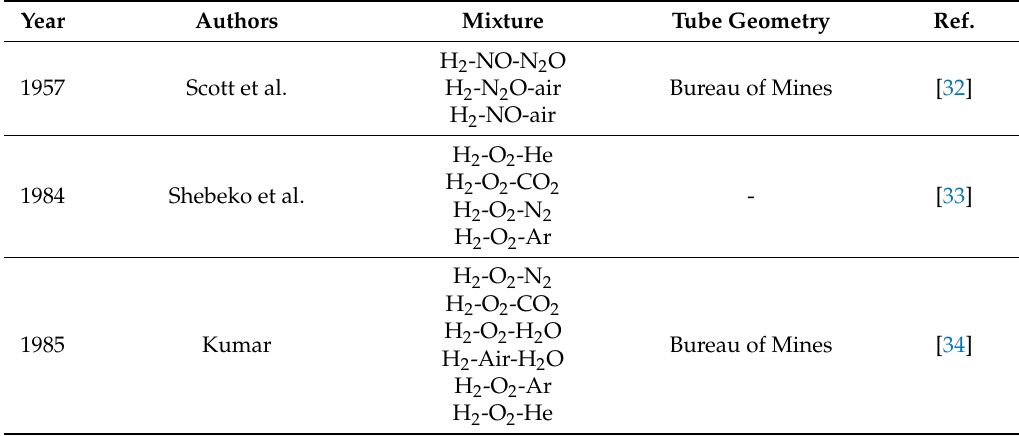
Table 3. Summary of experimental flammability limit studies since the